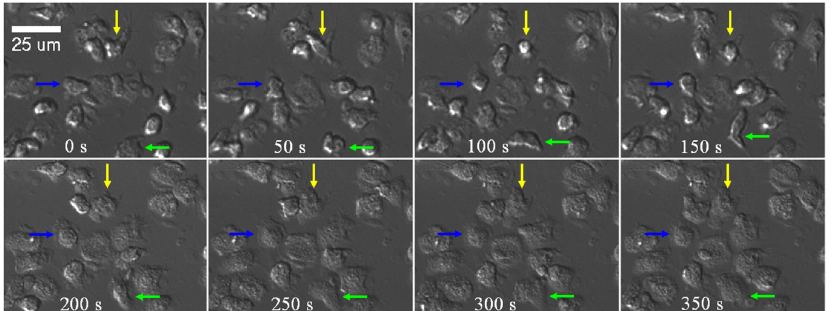
Fig. 3. UVA irradiation inhibited FMLP-induced migration in neutrophils. Three typical neutrophils showed random migration resulting from FMLP treatment, as indicated by colored arrows from 0 to 150 s. UVA treatment for 40 s (starting at 150 s) to the whole region of the image induced an inhibitory e®ect on cell migration shown from 200 to 350 s.